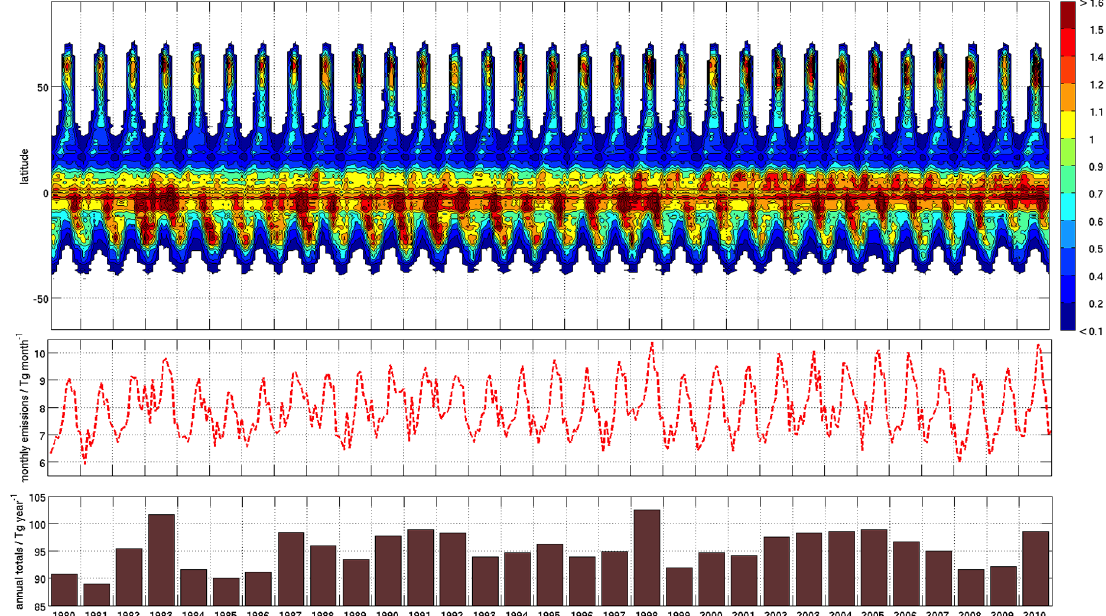
Figure 4. Zonal averages of monthly mean monoterpene emissions (mgm − 2 day − 1 ) (top panel), temporal profile of monoterpene global monthly totals (Tgmonth − 1 ) (mid-panel), global annual totals of monoterpene (Tgyr − 1 ) (bottom panel) for the period of 1980–2010 from the MEGAN–MACC data set. Note that the vertical axis for annual totals starts at 85Tgyr − 1